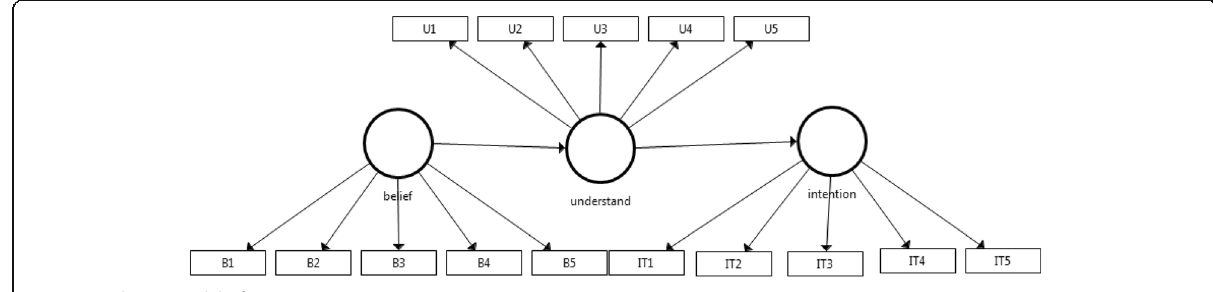
Fig. 2 Initial SEM model of STEM